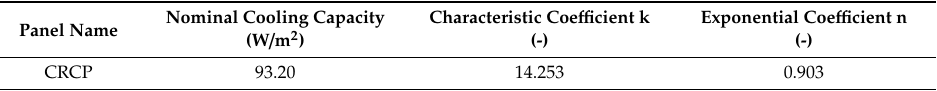
Figure 20. Test result for the cooling capacity of the CRCP. Table 18. Nominal cooling capacity of